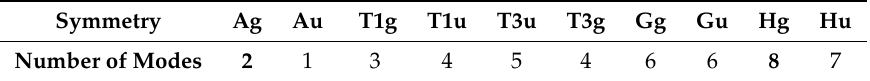
Table 1. The fundamental vibrational modes of C 60 . Highlighted modes are Raman active.